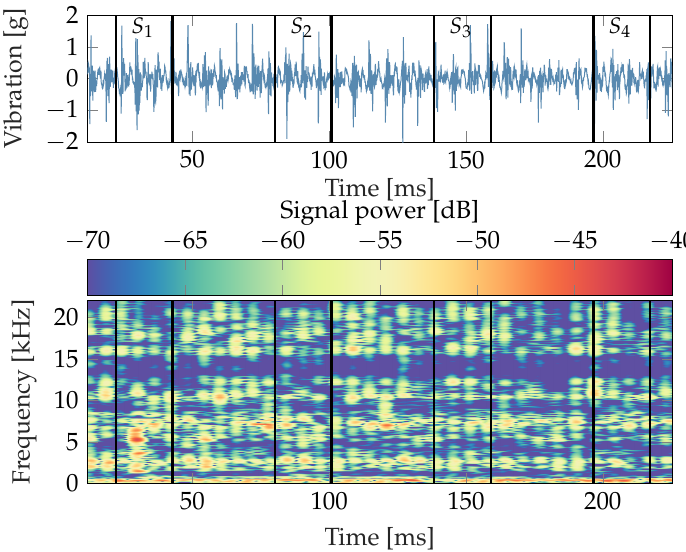
Figure 6. Vibration signal and spectrogram of the artificially damaged gear z 1 .